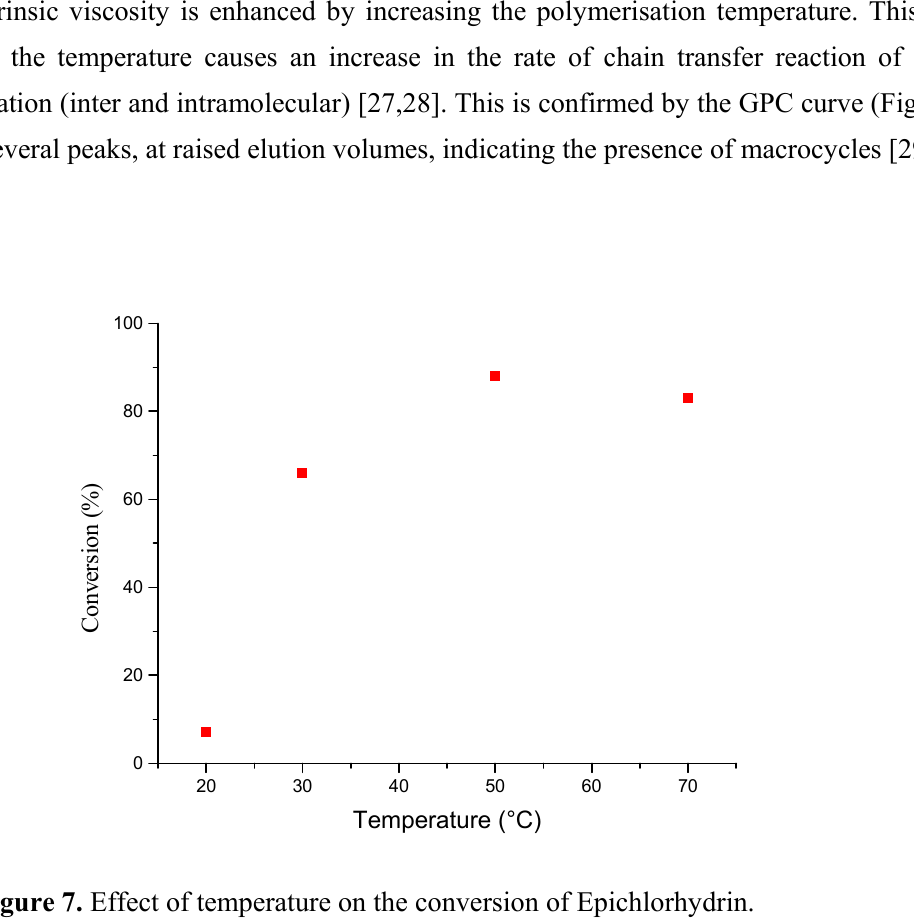
Figure 7. Effect of temperature on the conversion of